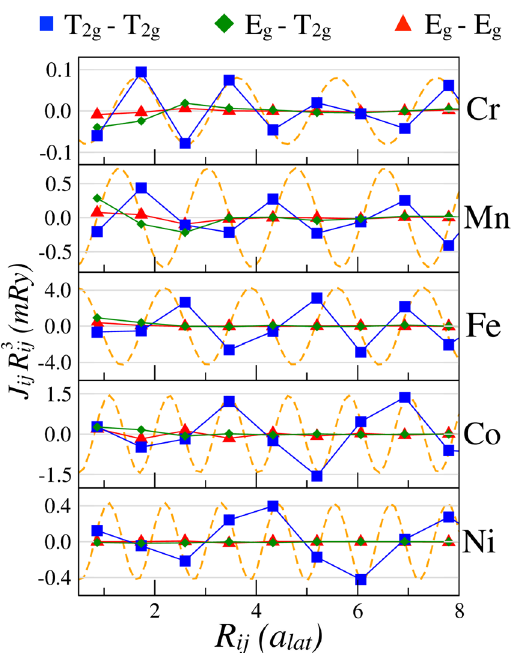
3 along the direction of the NN in bcc structure. Orange dashed lines show Figure 6. Orbitally-resolved J R ij ij analytical functions given by Eq. (1), whose periods were obtained analysing the band structures (see text). Here, for Mn and Fe, the analytical results are scaled by a factor 1/5 on y axis for presentation purposes, such that they fit within the relevant energy window.